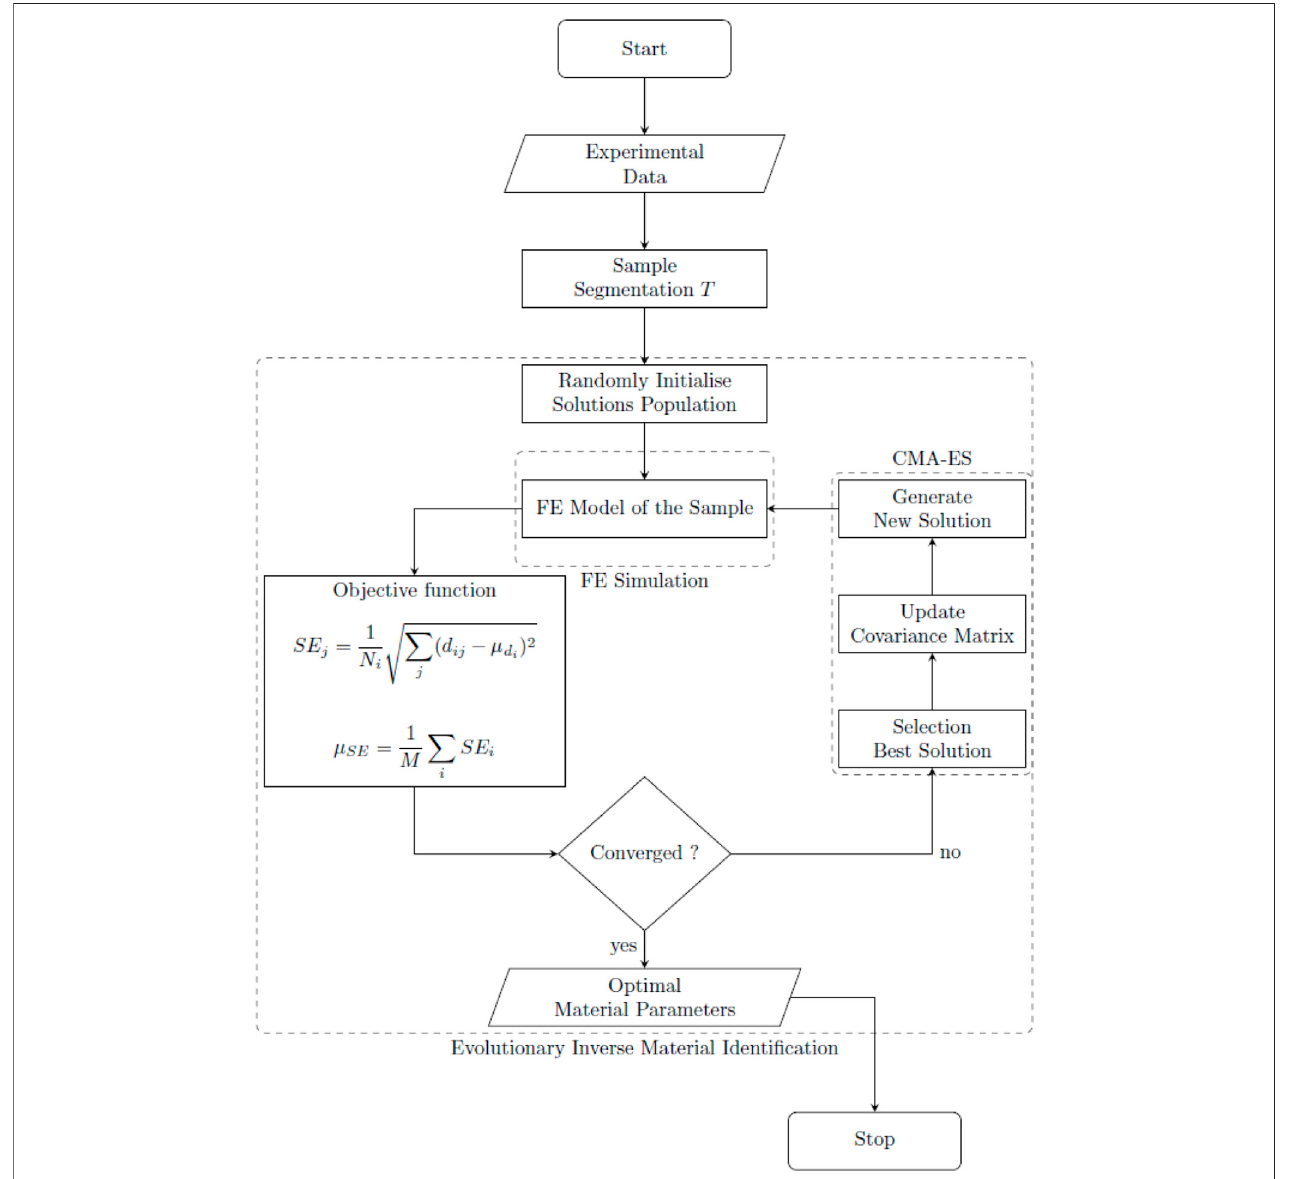
FIGURE 6 | Evolutionary Inverse Material Identi fi cation (EIMI) fl owchart.